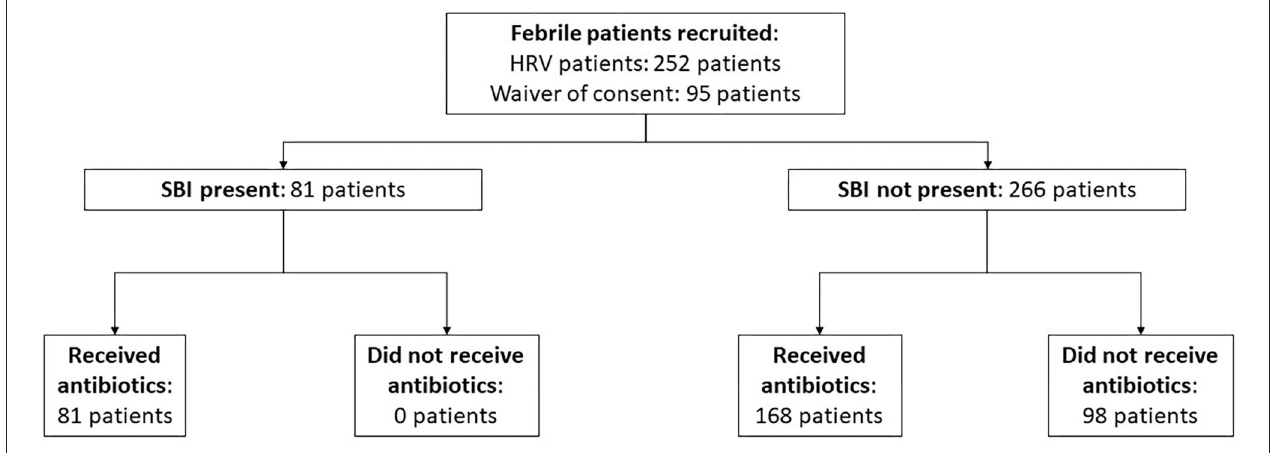
FIGURE 1 | Flowchart of patient